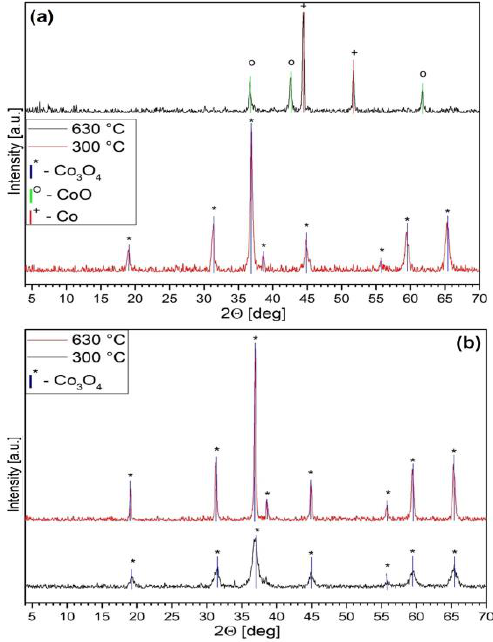
Figure 8. XRD of the decomposition products of compound 1 at 300 °C and 630 °C in ( a ) helium atmosphere and in ( b ) air.